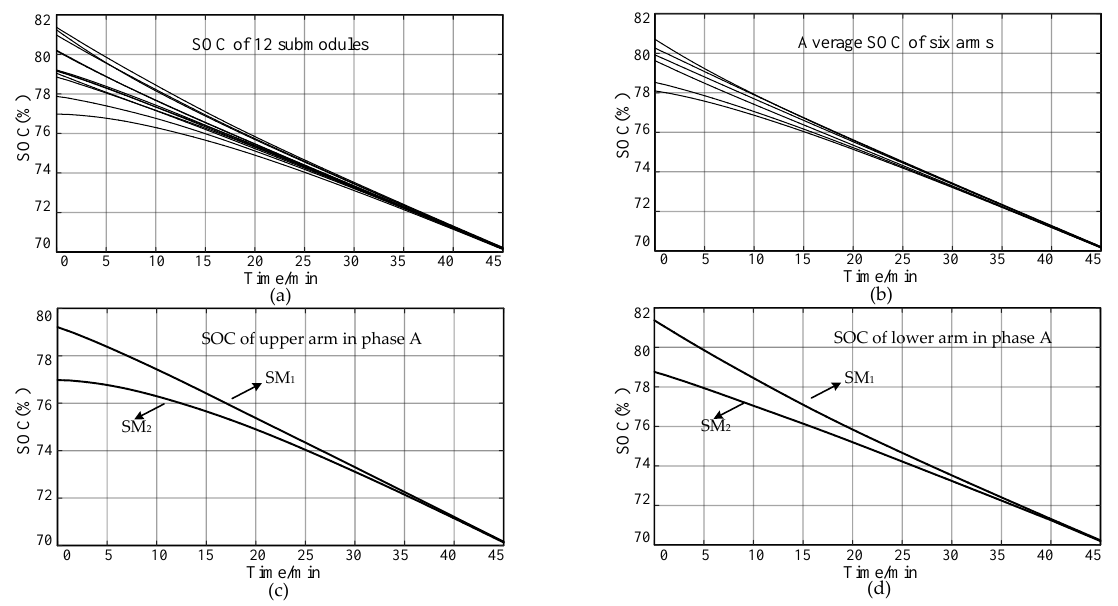
Figure 12. Experiment results of modified SOC balancing control method : ( a ) SOC of all submodules; ( b ) average SOC of phase arms; ( c ) SOC of upper arm in phase A; ( d ) SOC of lower arm in phase A .